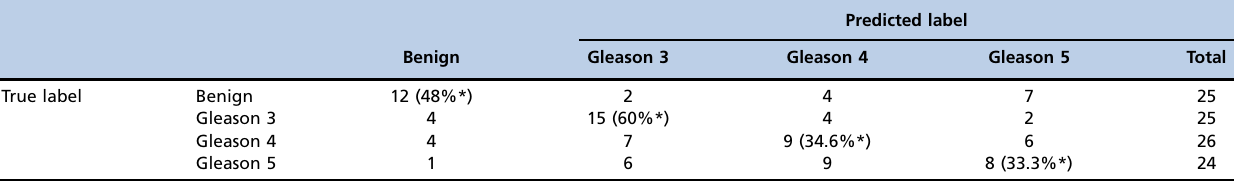
Predicted label